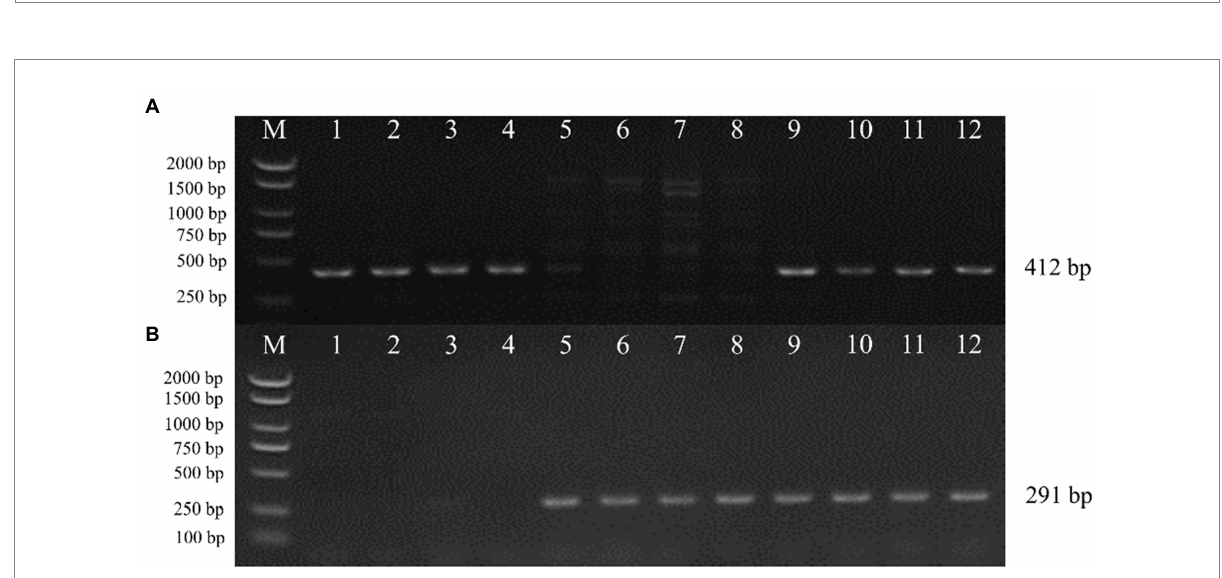
FIGURE 7 Mating type genes amplification of M. importuna transformants by PCR. Candidate heterokaryon strains were formed by paired culture of transformants harboring opposite mating type genes. (A) MAT1-1-1 gene amplification. (B) MAT1-2-1 gene amplification. Lanes1–4, M04M24 strains with the insertion of pEH2B plasmid, showed mat 1-1-1 genotype; Lanes 5–8, M04M26 strains with the insertion of pMH2B plasmid, showed mat 1-2-1 genotype; Lanes 9–12, randomly selected candidate heterokaryon strains, both mating type genes were detected. M, BM2000 marker (Biomed, Beijing, China). The expected size is indicated on the